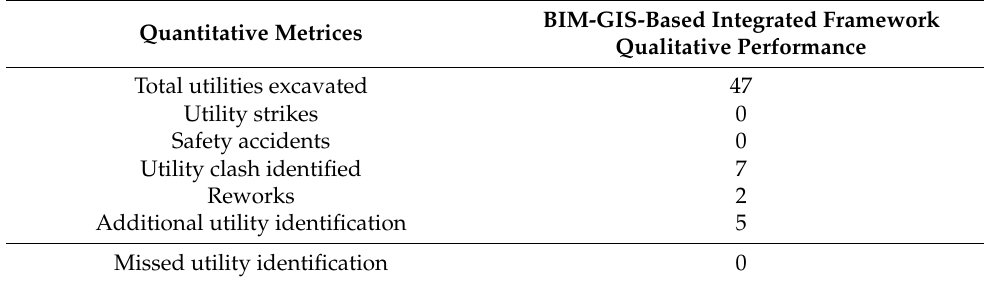
Table 3. Quantitative evaluation of BIM-GIS-based underground utility management system. Quantitative